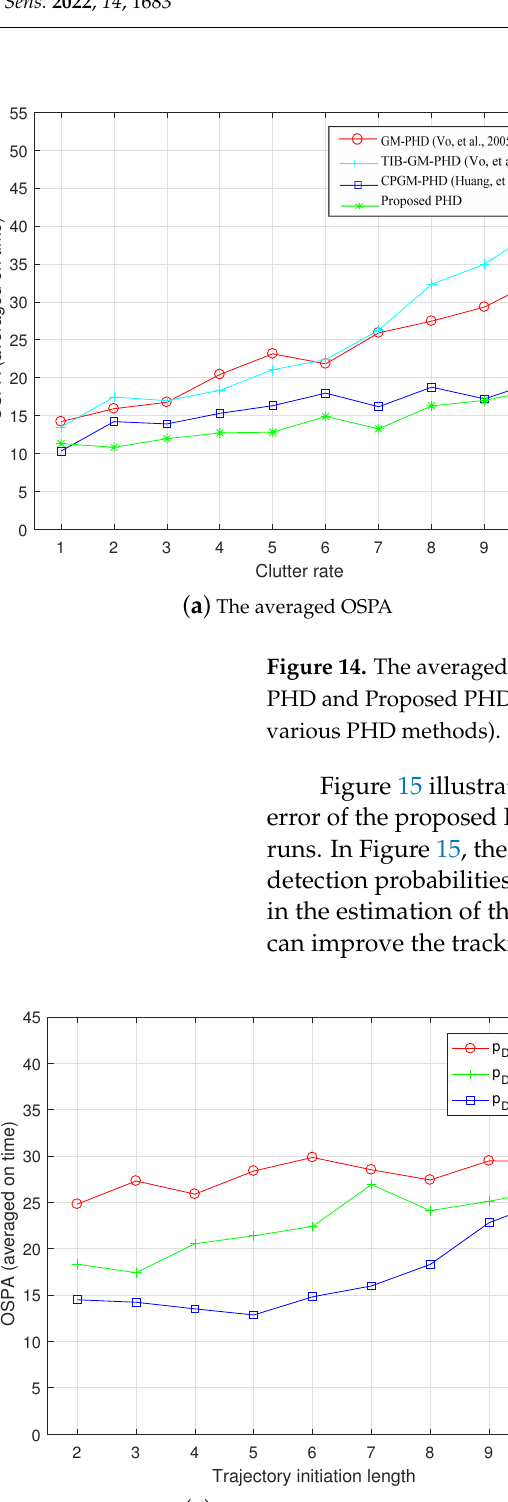
( b ) The sum of cardinality error Figure 15. The averaged OSPA and the sum of cardinality error of GM-PHD, TIB-GM-PHD, CPGM- PHD and Proposed PHD with different trajectory initiation